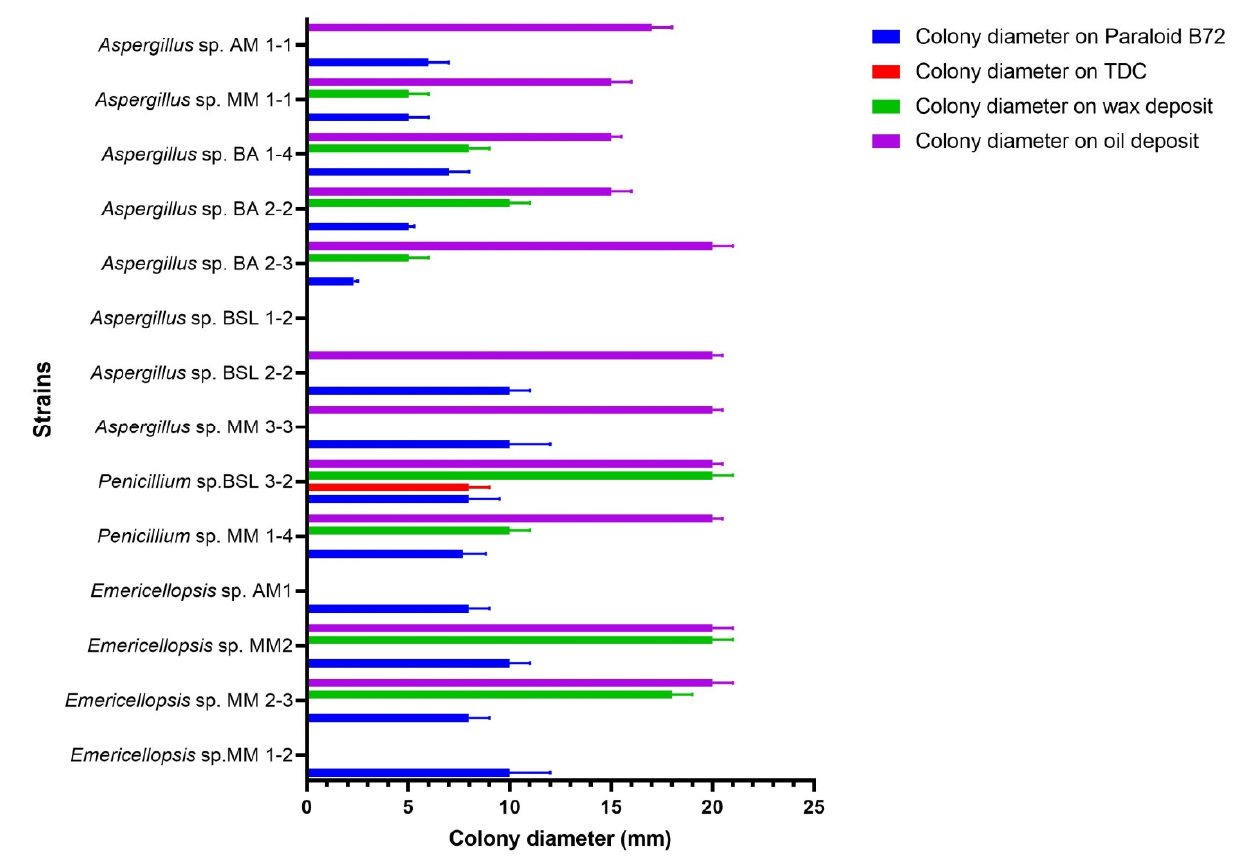
Figure 5. Qualitative evaluation of lipase activity on Paraloid B72, TDC, BW and SO (slide cultures method).